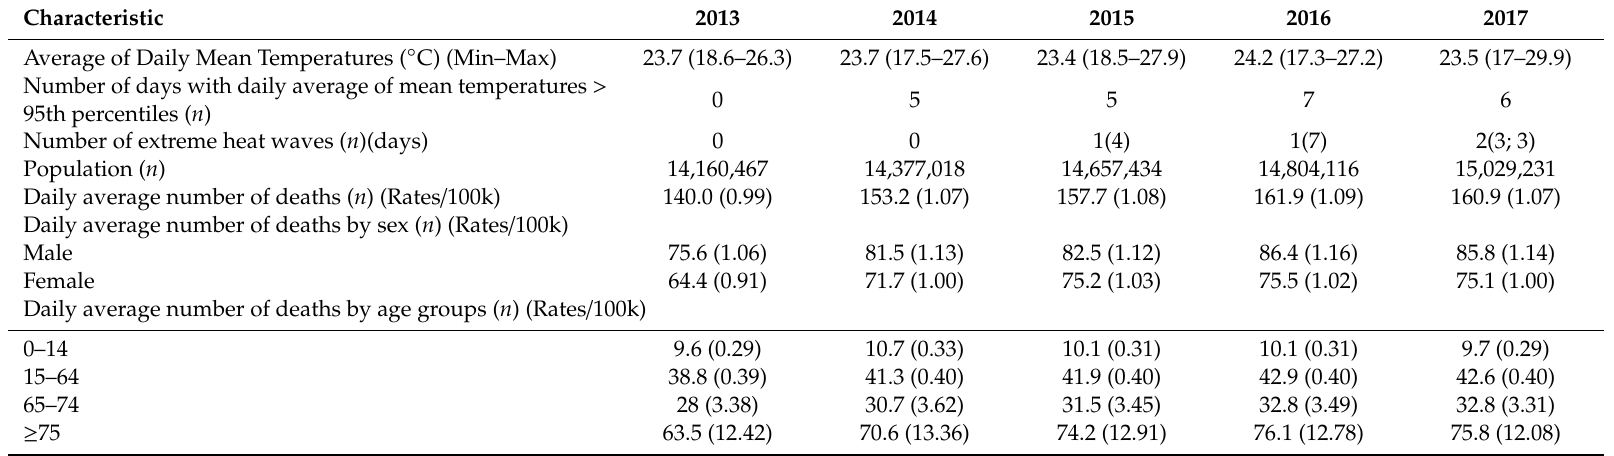
Table 1. Descriptive statistics of temperatures and deaths by years (for